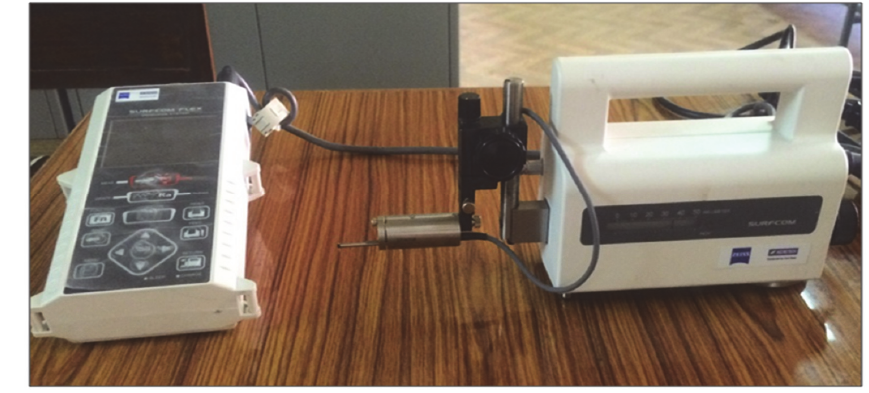
Fig. 4. Photographic view of Surfcomflex instrument